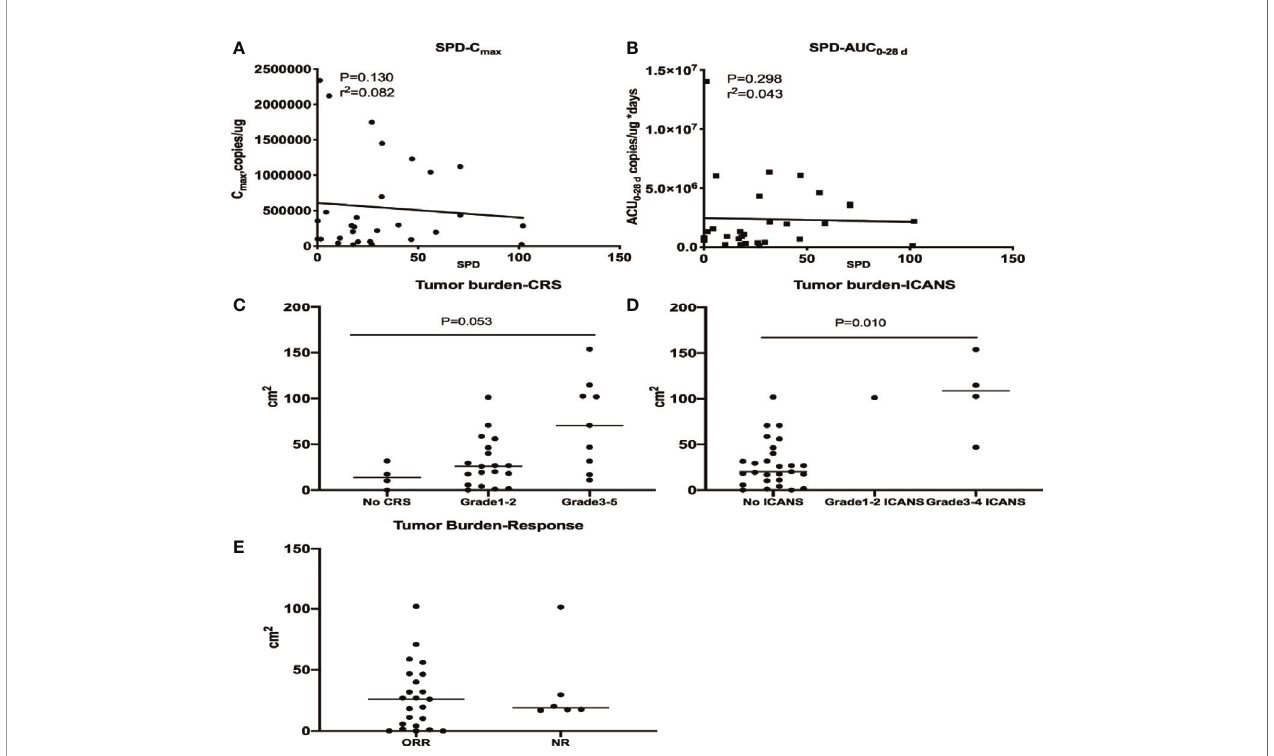
FIGURE 6 | Relationships between the tumour burden and cellular kinetics, CRS, ICANS and ef fi cacy. The baseline tumor burden did not affect C max (A) and AUC 0 – 28 d (B) . A higher tumor burden was observed in patients with grade ≥ 3 CRS (C) and ICANS (D) , while no apparent correlation was identi fi ed between the tumor burden and response (E)